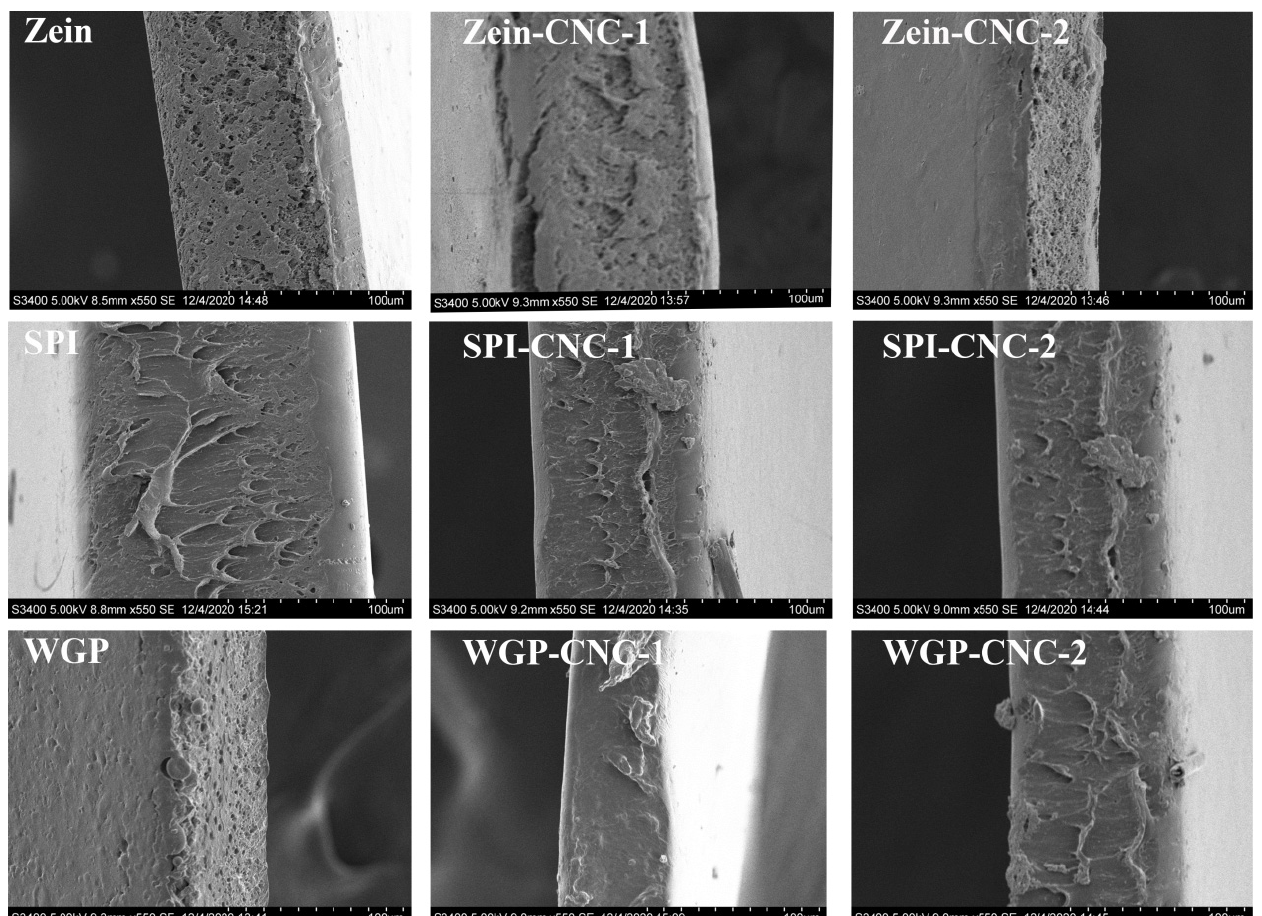
Figure 7. SEM images of cross-section of the Zein/SPI/WGP-based films (Magnifications are 550×).